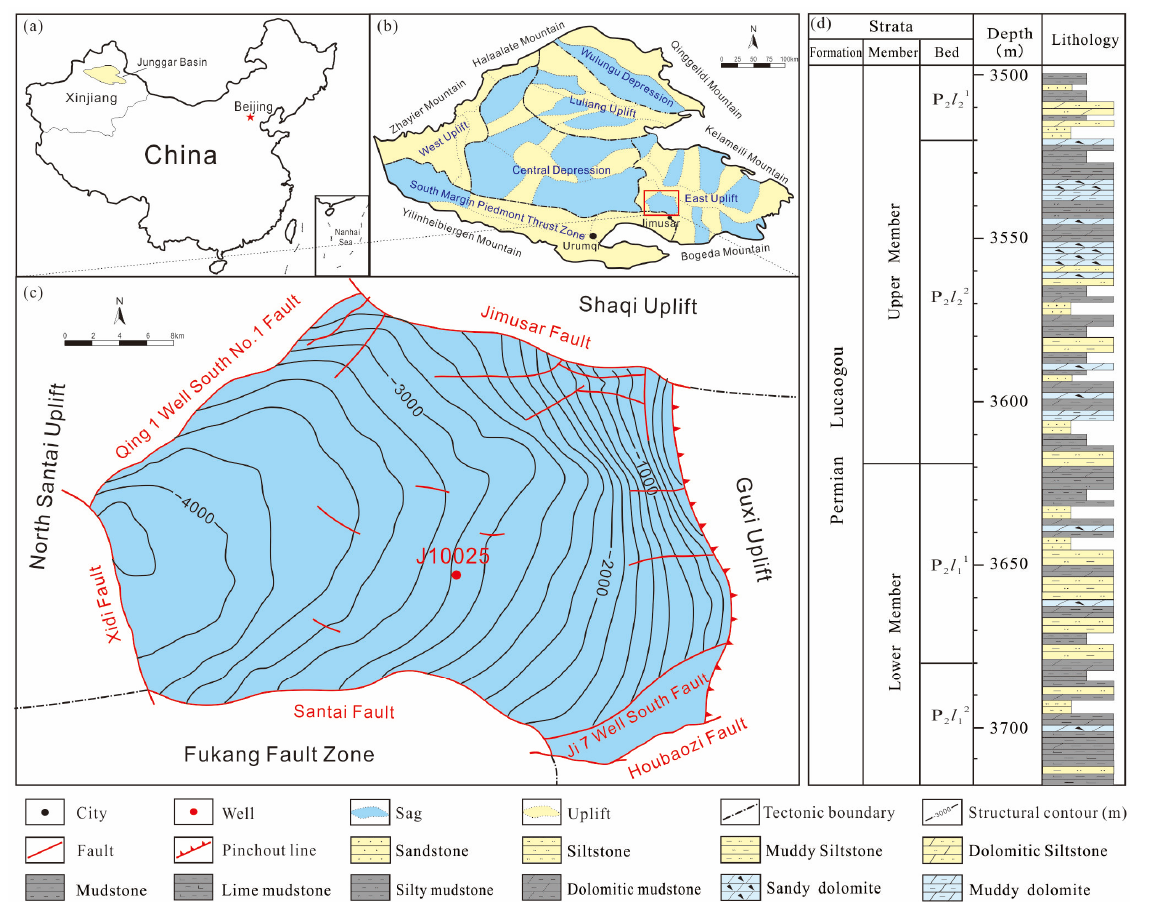
Figure 1. Geological map of the study area and stratigraphic column of the study well (modified from [42]). ( a ) Location of the Junggar Basin in China. ( b ) Structural map of the Junggar Basin. ( c ) Structural framework of the Jimsar Sag and location of the study well. ( d ) Stratigraphic column of Well J10025.